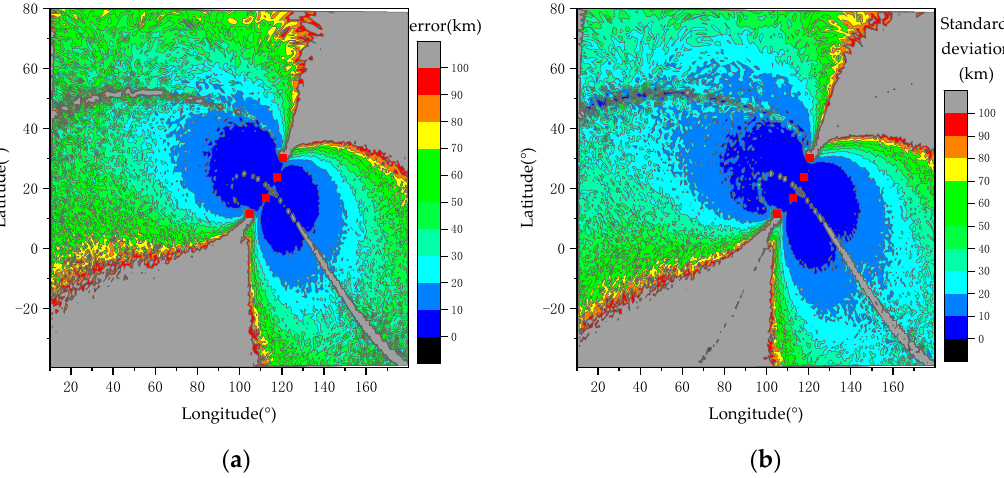
Figure 9. The location error and standard deviation of the linear site distribution. ( a ) Location error distribution. ( b ) Standard deviation distribution. The 4 sites are distributed almost in a straight line. Each red box represents a site.